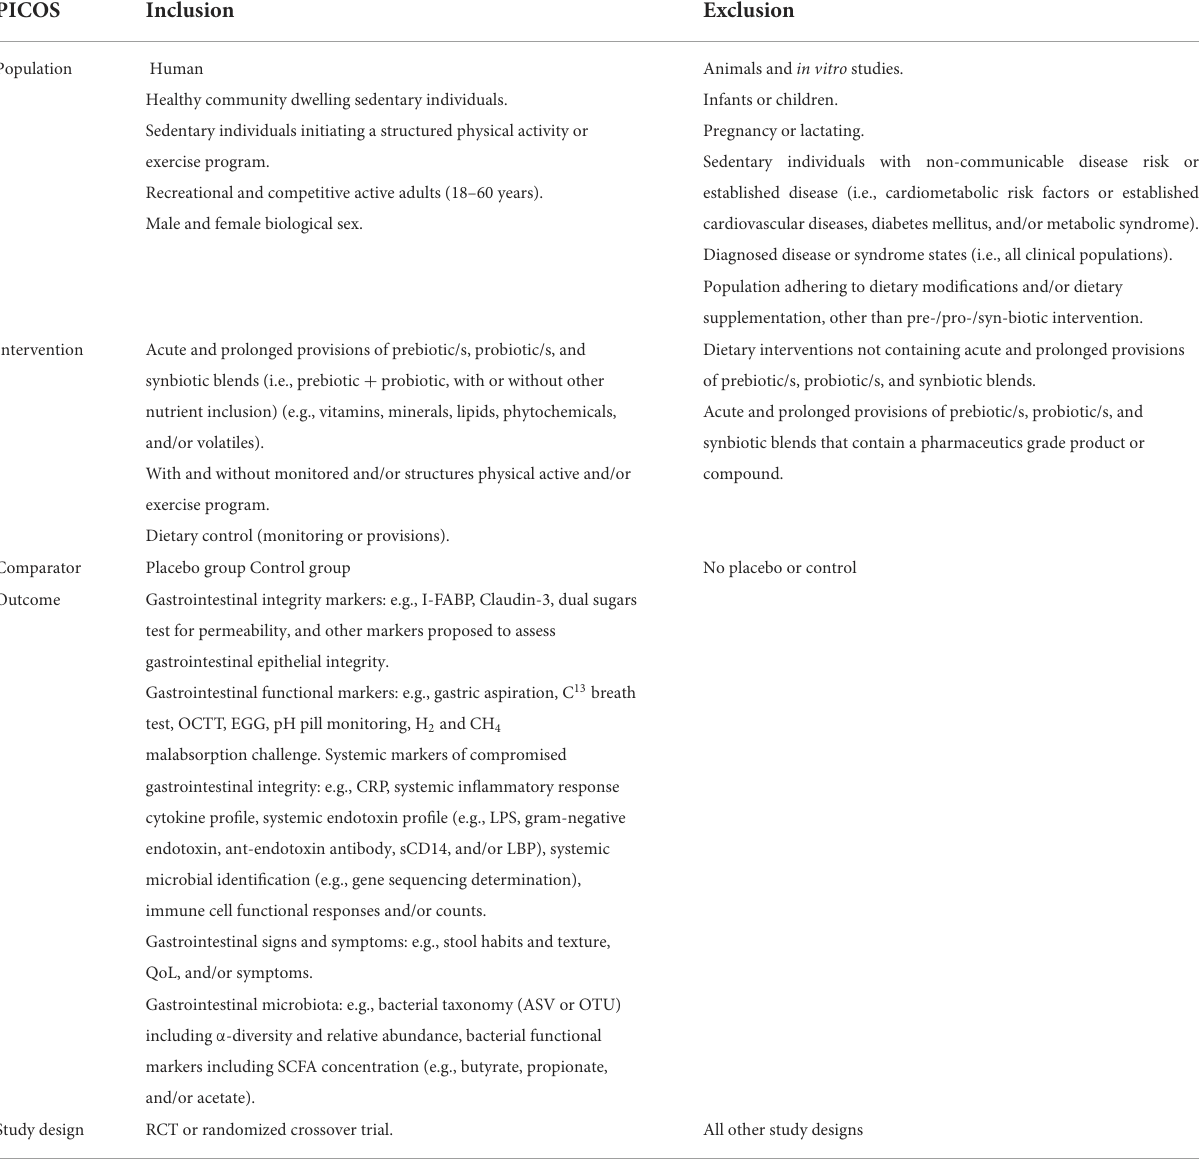
TABLE 2 PICOS table, showing the inclusion and exclusion criteria for study population, intervention, comparator, outcome/s, and study design. PICOS Inclusion